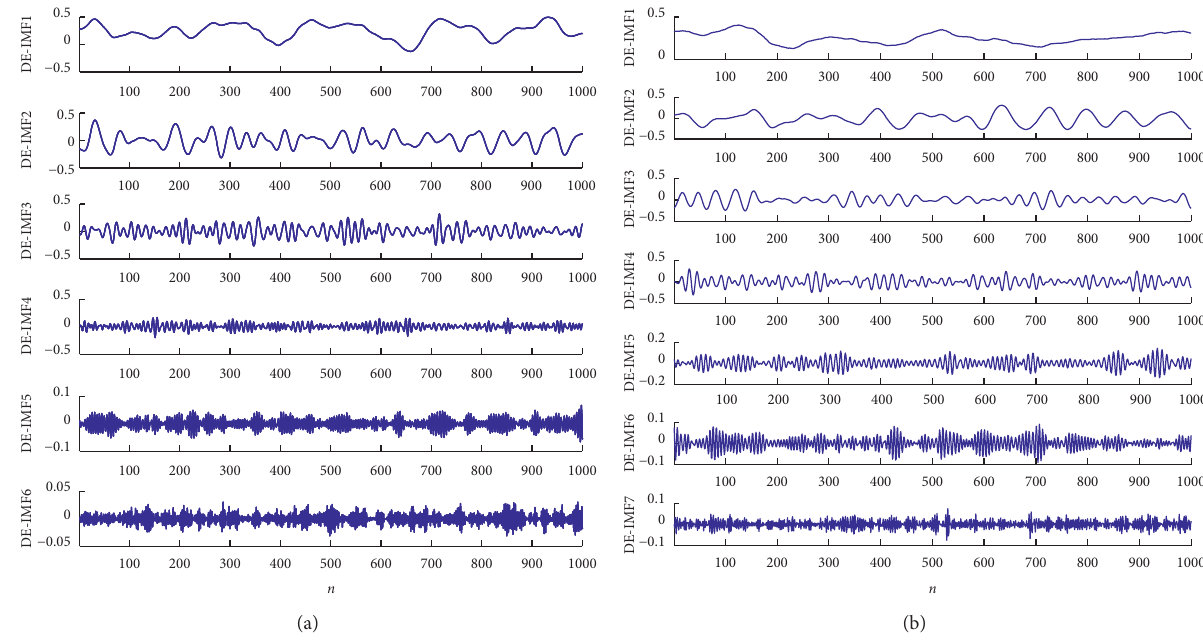
Figure 10: Recombination component processed by the VMD-DE method: (a) data set A; (b) data set B.